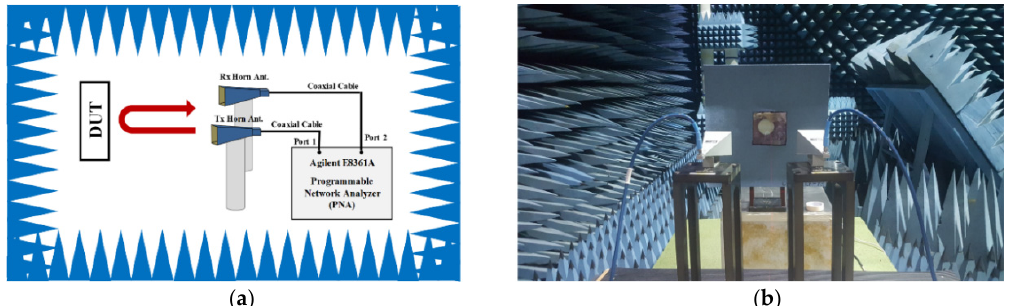
Figure 8. ( a ) Schematic and ( b ) a photograph of the measurement setup.